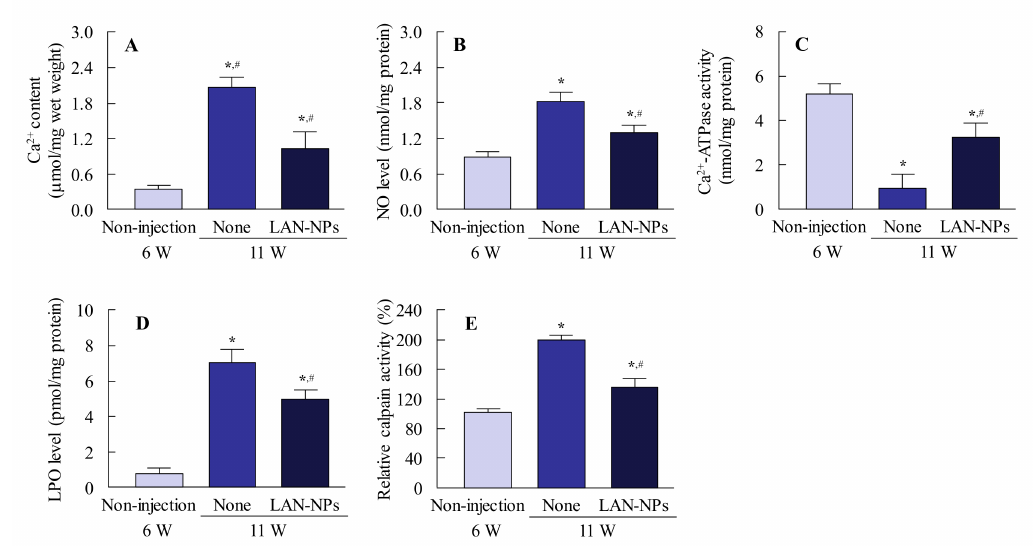
Figure 6. Changes in Ca 2 + contents, NO levels, Ca 2 + -ATPase activity, and LPO levels in the lenses of 11-week-old SCR-C intravitreously injected with LAN-NPs. LAN-NPs were injected intravitreously into 6-week-old SCR-C for 5 weeks (once per 2 days). ( A ) Ca 2 + contents in the lenses of SCR-C with or without LAN-NP injection. ( B ) NO levels in the lenses of SCR-C with or without LAN-NP injection. ( C ) Ca 2 + -ATPase activity in the lenses of SCR-C with or without LAN-NP injection. ( D ) LPO levels in the lenses of SCR-C with or without LAN-NP injection. ( E ) Calpain activities in the lenses of SCR-C with or without LAN-NPs injection. Non-injection, non-injected SCR-C aged 6 weeks; None, non-injected SCR-C aged 11 weeks; LAN-NPs, LAN-NPs injected SCR-C aged 11 weeks; n = 6–11; * p < 0.05, vs. Non-injection for each group. # p < 0.05, vs. None for each group. The changes in Ca 2 + contents, NO levels, Ca 2 + -ATPase activity, LPO, and calpain levels in the lenses of SCR-C were attenuated by the repeated injection of